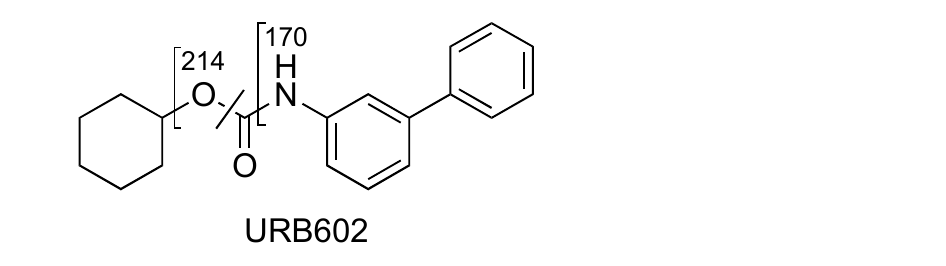
Figure 11 . Representation of the collisional-induced fragment ions of URB602 compound.